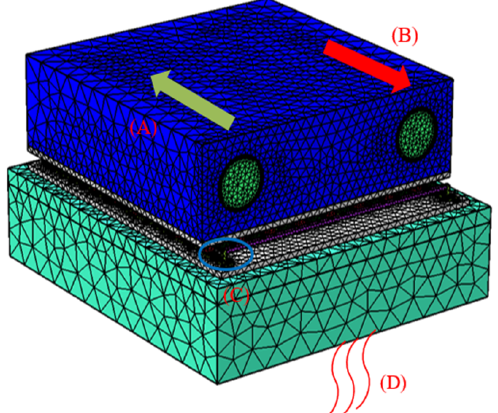
Figure 4. Boundary conditions of the simplified TEG system. A: inlet boundary of cooling water. B: outlet boundary of cooling water. C: grounded boundary. D: hot source boundary of TEG system.